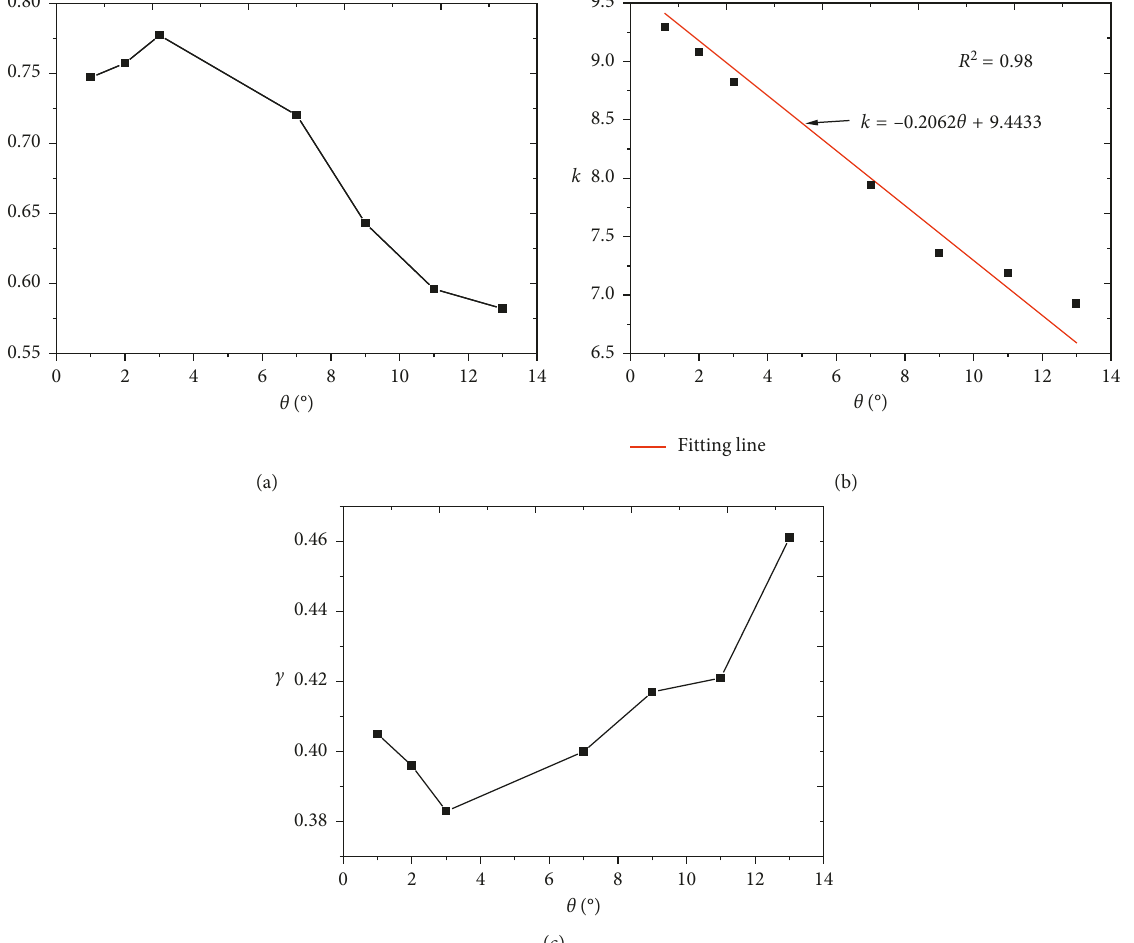
Figure 11: The relationships between parameters in equation (3) and bed slopes. (a) The relationship between η and bed slopes. (b) The relationship between k and bed slopes. (c) The relationship between c and bed